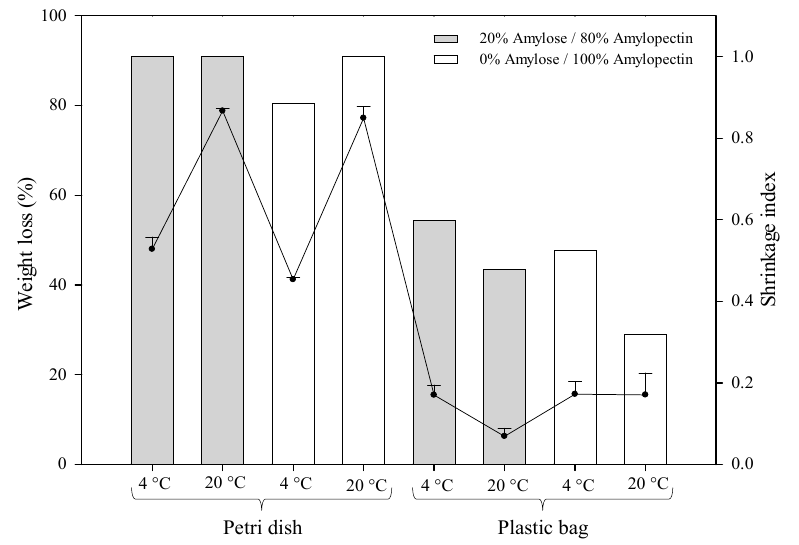
Figure 3. Shrinkage index (bars/right y axis) and weight loss (line/left y axis) of the different hydrogels investigated after 30 days of storage.